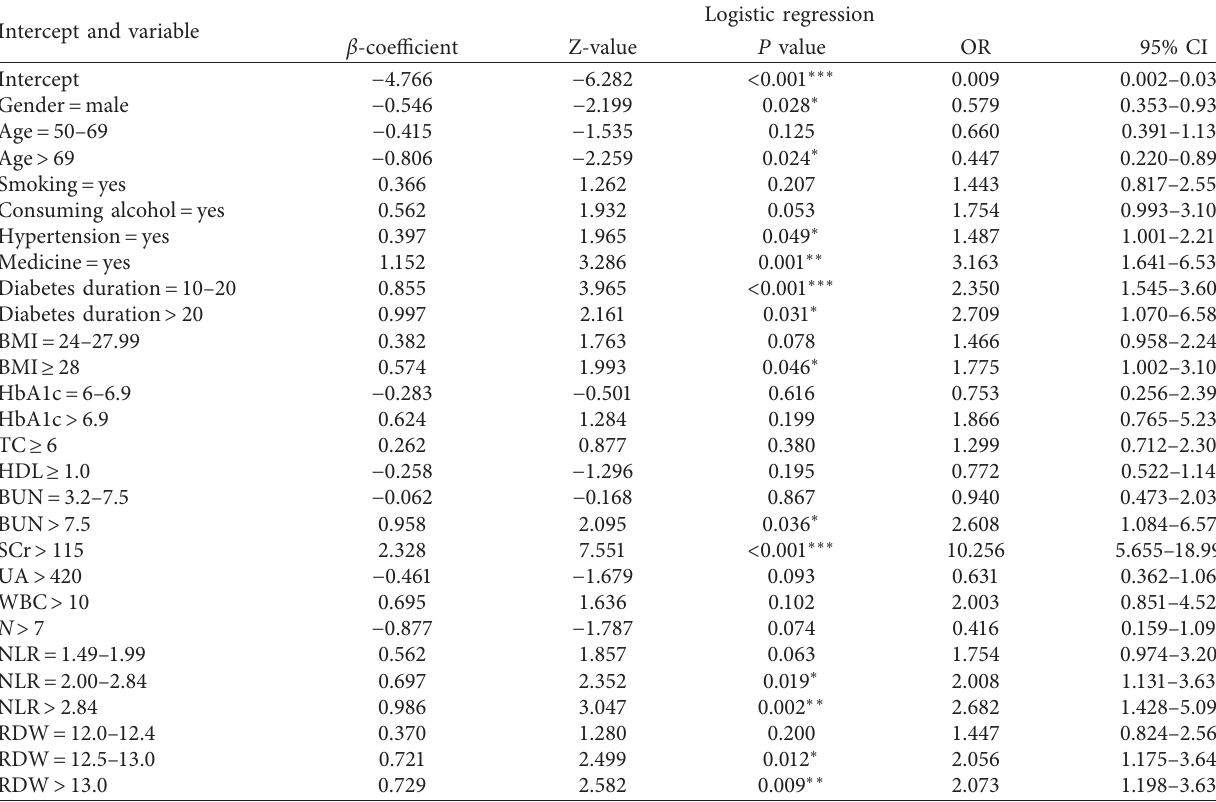
Table 2: Screening out predictive factors for DN incidence risk in patients with T2DM by logistic